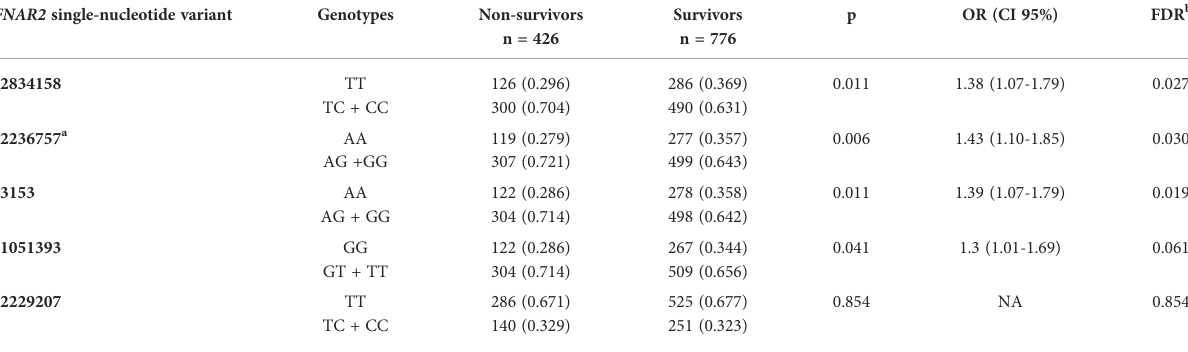
TABLE 3 Dominant model analyses for IFNAR2 genetic variants were included in the study. IFNAR2 single-nucleotide